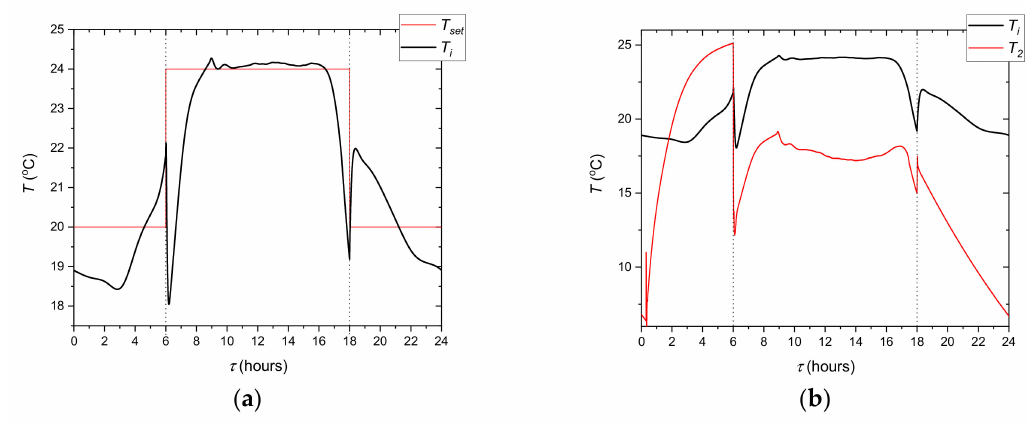
Figure 18. Evolution of the calculated temperature inside of the office T i ( a ) and the measured inlet HTF temperature T 2 ( b ) (cycle no 3).